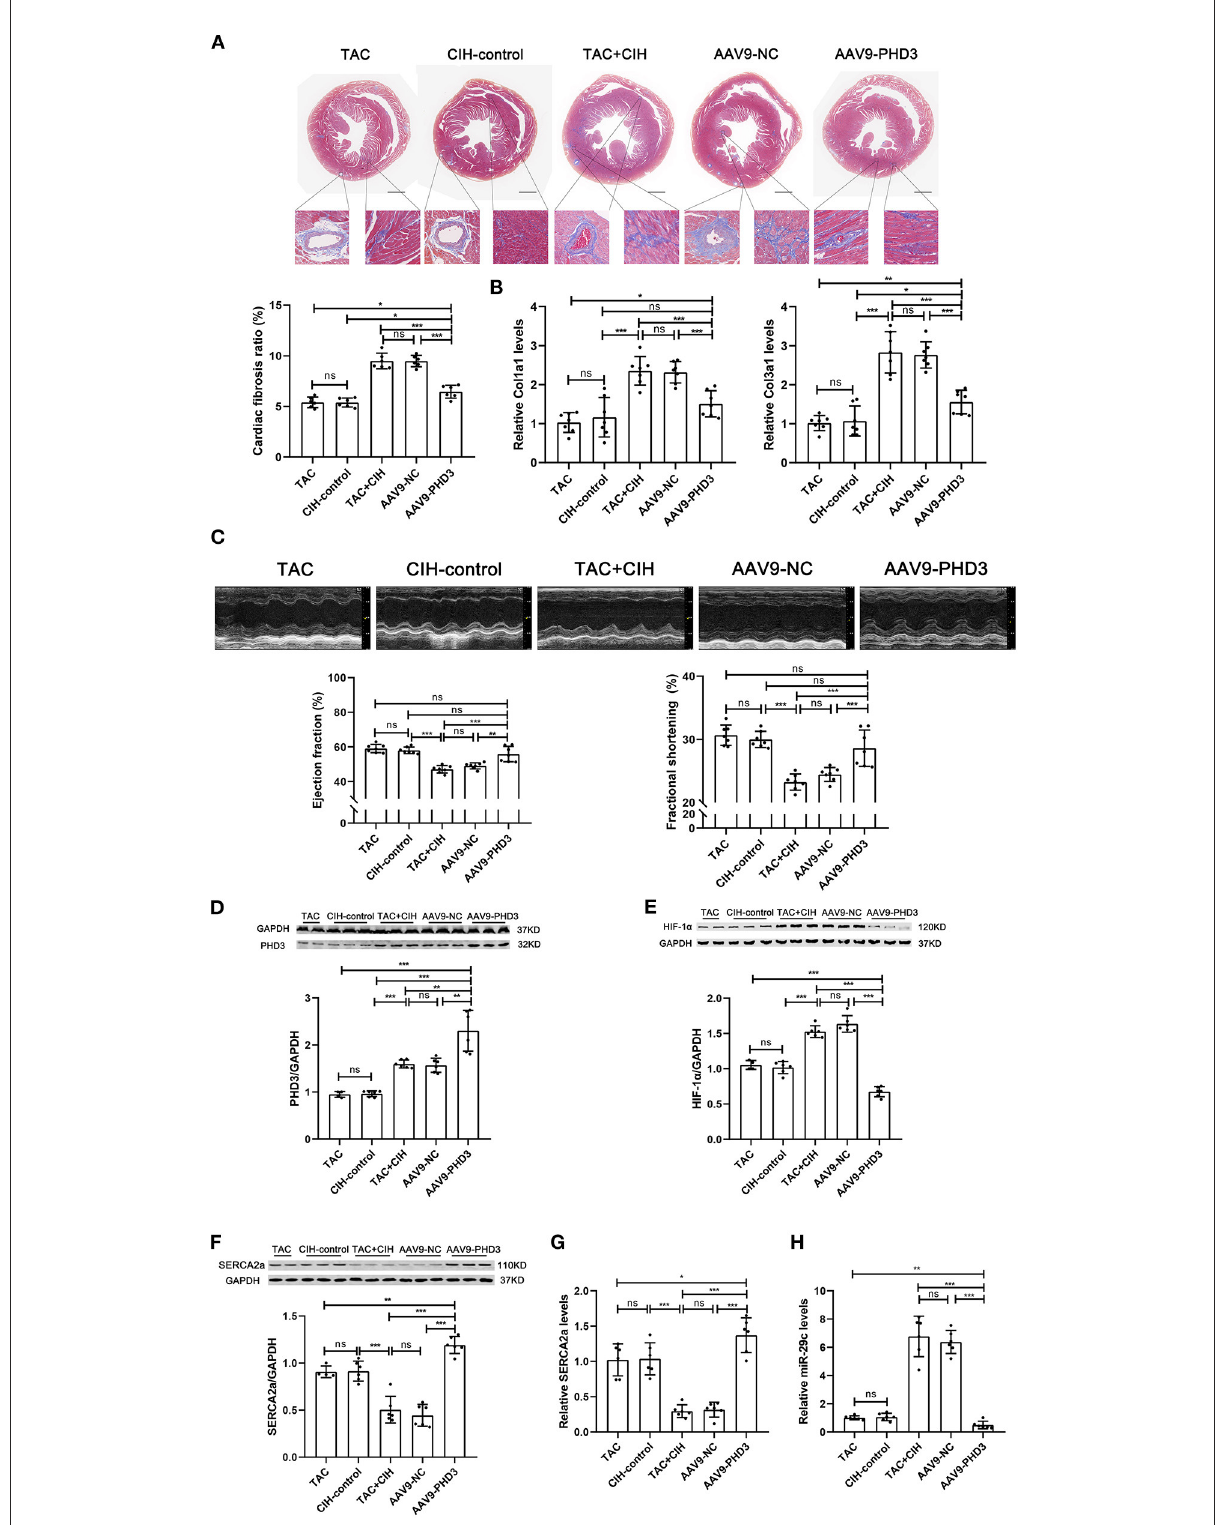
FIGURE6 PHD3 overexpression downregulates HIF-1 α and miR-29 expression to stabilize SERCA2a expression and alleviate cardiac fibrosis and cardiac dysfunction. (A) Masson staining of heart cross-section images and representative perivascular and interstitial fibrosis images magnified in boxes; the fibrosis area ratio was quantified. n = 7; *** p < 0.001. (B) Real-time PCR analysis of relative Col1a1 and Col3a1 levels in heart tissue at